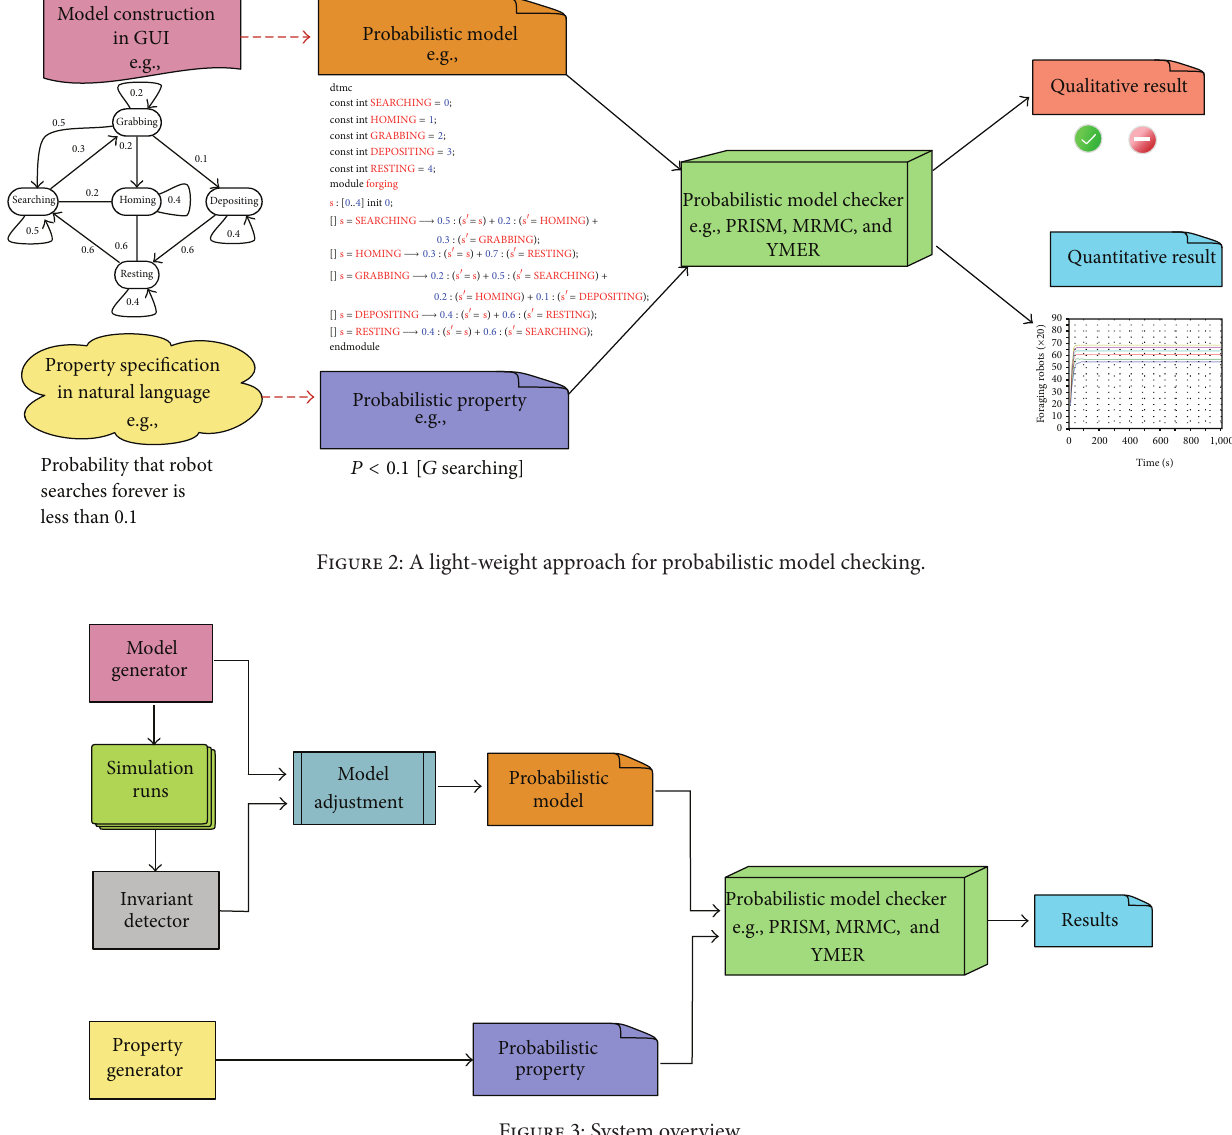
Figure 3: System